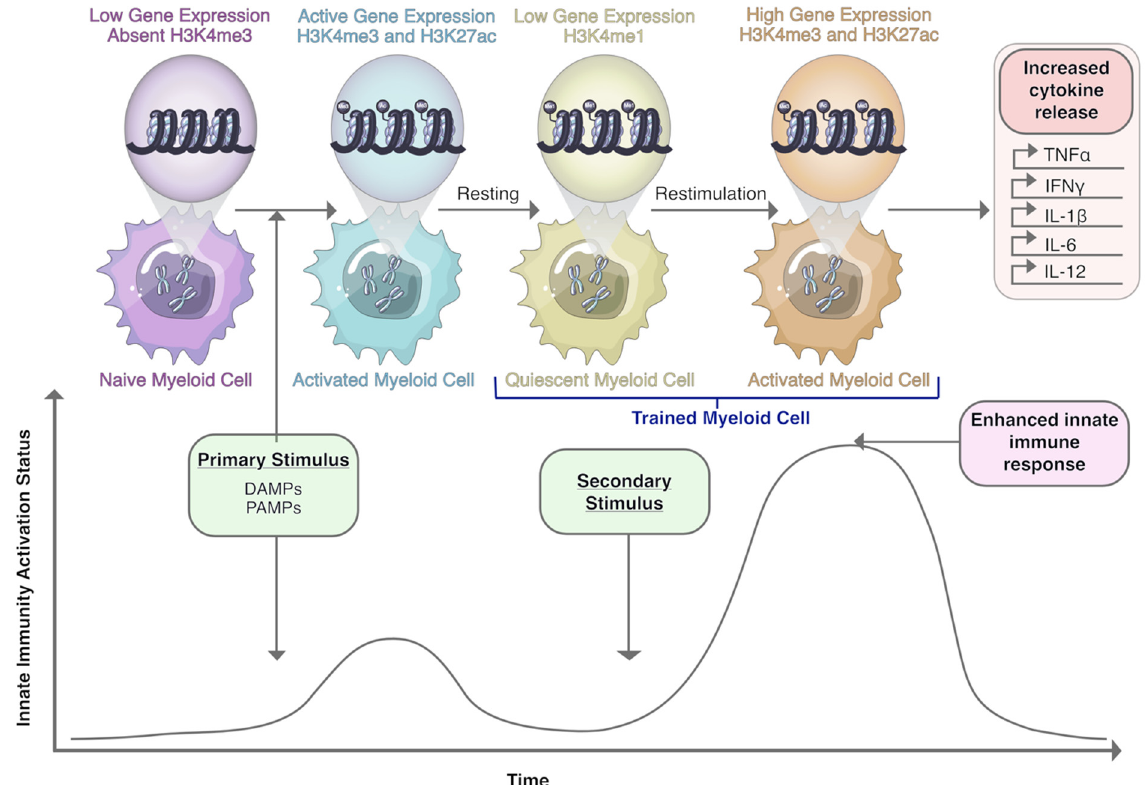
Figure 2. Acquisition of trained immunity in myeloid cells involves epigenetic reprogramming and results in enhanced inflammatory properties in innate immune cells. In response to primary exposure to DAMPs or PAMPs, the highly condensed chromatin of naïve myeloid cells relaxes following acquisition of methylation marks on histone proteins. Upon re-exposure to similar, but not necessarily identical, stimuli, the presence of these epigenetic modifications enables rapid transcription and expression of pro-inflammatory cytokines resulting in an enhanced innate immune response. H3K4me3, histone 3 lysine 4 trimethylation. H3K4me1, histone 3 lysine 4 monomethylation; H3K27ac, histone 3 lysine 27 acetylation; DAMPs, damage-associated molecular patterns; PAMPs, pathogen-associated molecular patterns; TNF α , tumor-necrosis factor- α ; IFN γ , interferon- γ ; IL-1 β , interleukin-1 β ; IL-6, interleukin-6; IL-12, interleukin-12; me, methylation; ac, acetylation.